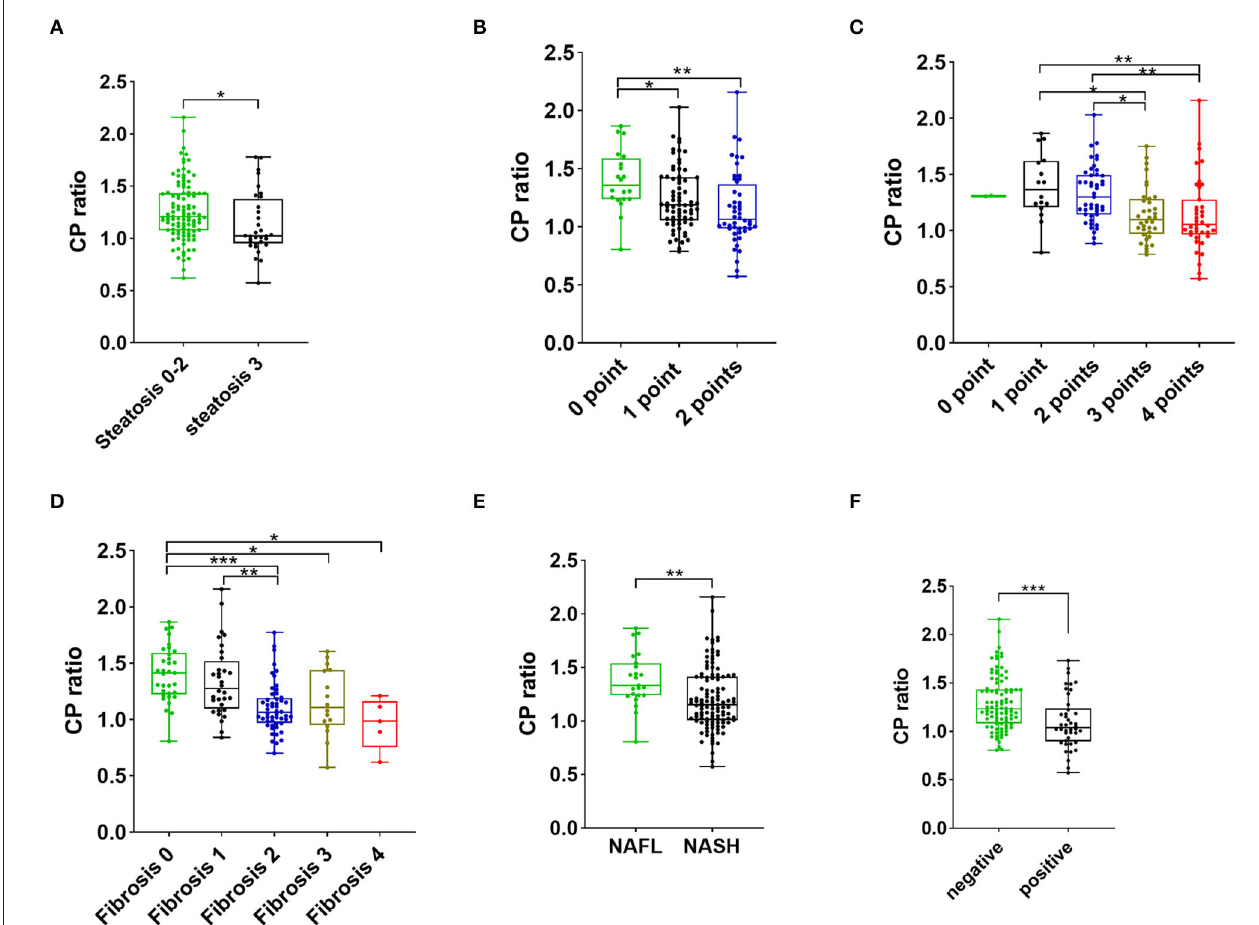
FIGURE 2 | The CP ratio of patients with steatosis stages 0–2 vs. 3 (A) , with different scores of ballooning (B) , with various scores of inflammation activity (C) , with different grades of fibrosis (D) , with NAFL and NASH (E) , and with negative and positive Perl’s staining (F) . The value within the box ranges from the 25 th to the 75 th percentiles. The median is shown by the horizontal bar. The vertical bars represent the values between the minimum and the maximum. The * indicates as p < 0.05, ** as p < 0.01, and *** as p < 0.001. Abbreviations: CP, ceruloplasmin; NAFL, non-alcoholic fatty liver; NASH, non-alcoholic steatohepatitis.